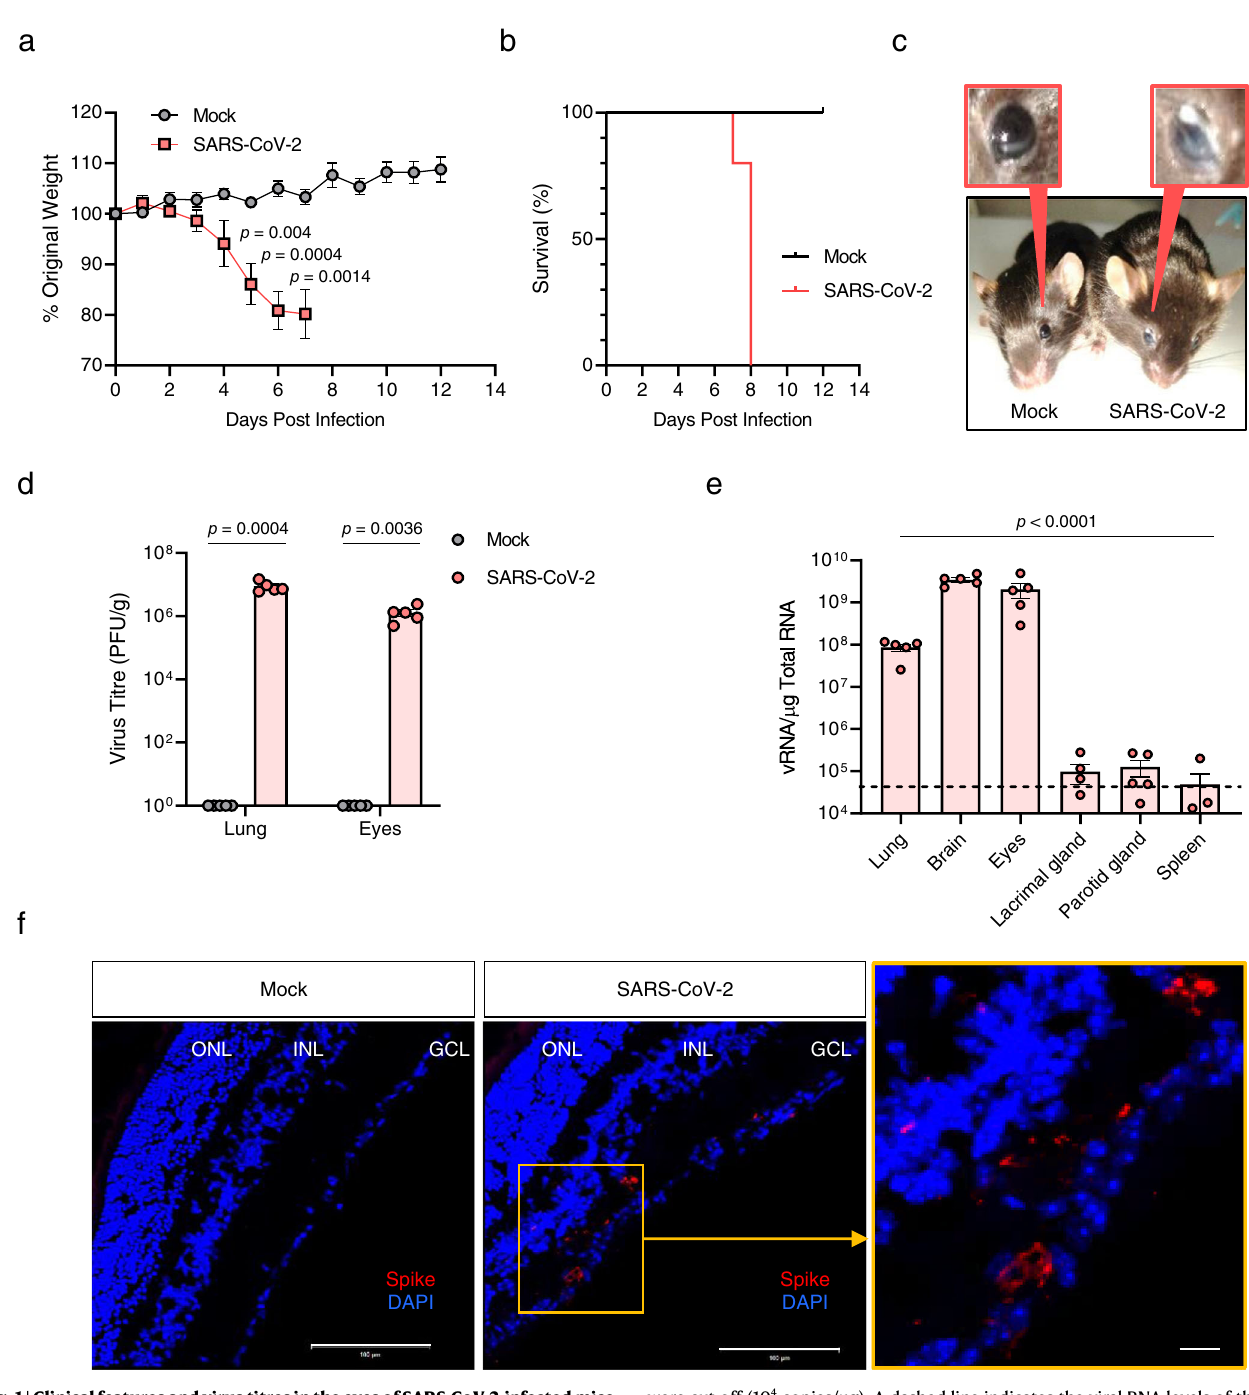
were cut-off (10 4 copies/ μ g). A dashed line indicates the viral RNA levels of the spleen as a limit of detection. f Representative confocal images of immuno- fl uorescence stained retinal sections of IN-infected mice ( n =3 per group) for viral spike (S) protein (red) at 6 dpi. DAPI staining (blue) was used to visualise nuclei of the ganglion cell layer (GCL), inner nuclear layer (INL), and outer-nuclear layer (ONL) in the retinal cross-section. Scale bar=100 μ m. Symbols represent means± SEM. Statistically signi fi cant differences between the groups were determined using multiple two-tailed t -tests ( a ), unpaired two-tailed t -test ( d ) or one-way ANOVA ( e ). SARS-CoV-2: severe acute respiratory syndrome coronavirus 2; PFU plaque-forming unit, vRNA viral RNA, dpi days